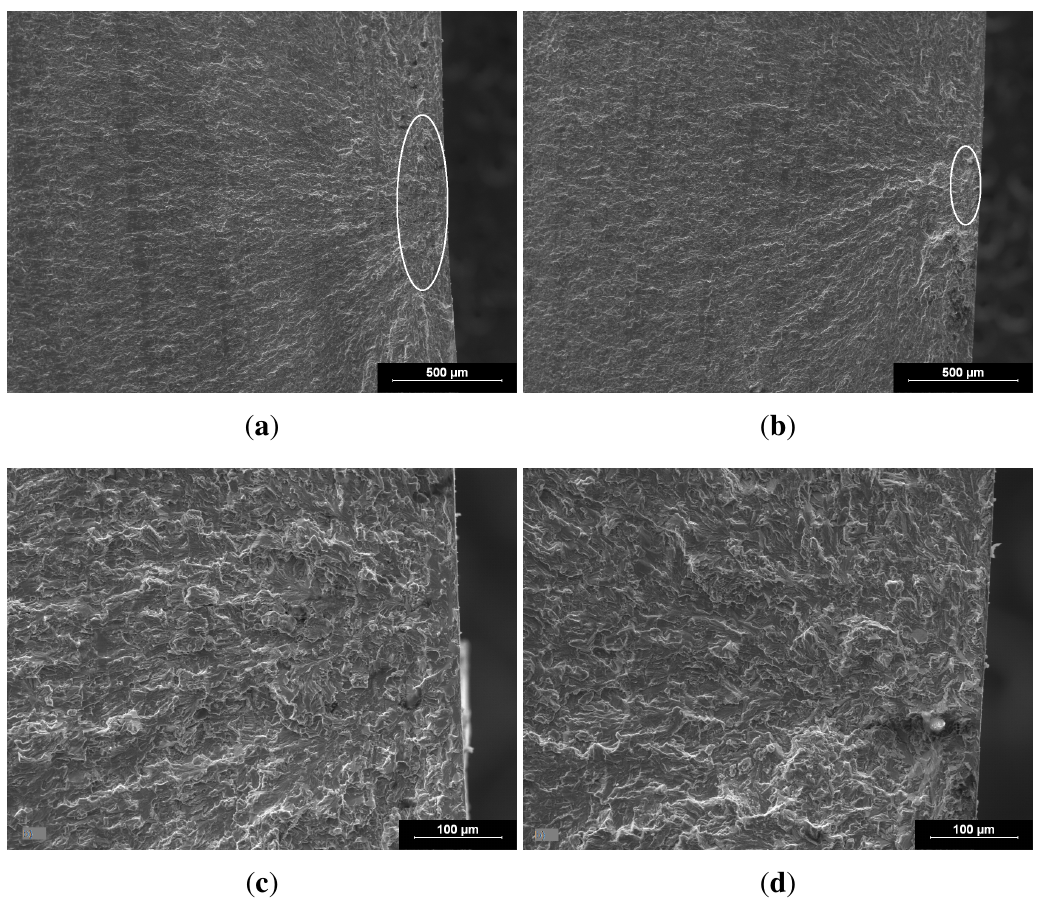
= σ + RS . maxlocal maxapplied